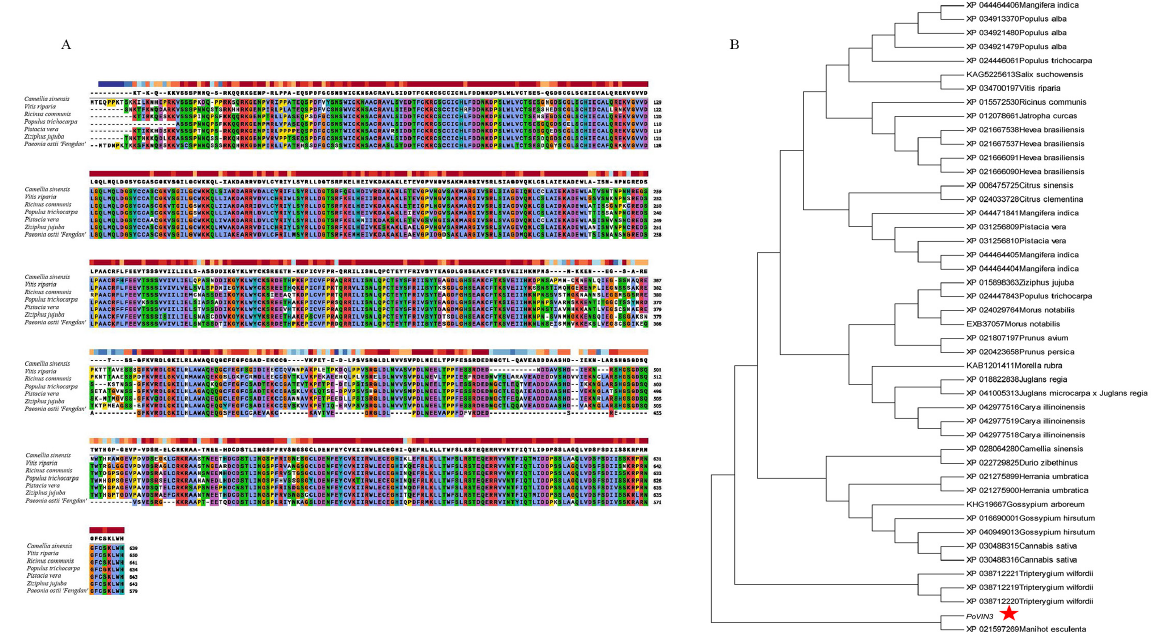
Figure 2. Multiple sequence alignment ( A ) and phylogenetic relationship ( B ) of PoVIN3 − encoded protein and VIN3 − encoded protein from other plant species. The red asterisk represented the PoVIN3 − encoded